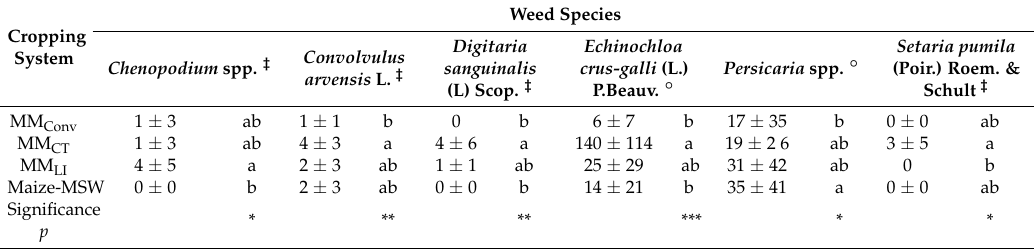
Figure 3. Mean weed biomass at three stages of maize growth in the four cropping systems (MM Conv : conventional maize monoculture; MM CT : conservation tillage maize monoculture; MM LI : low-input maize monoculture; Maize-MSW: integrated maize rotation). Weed biomass at the 6–8 leaf stage was sampled only in 2014 and 2015 ( N = 4 quadrats per cropping system) whereas weed biomass at the flowering and maturity stage was sampled from 2011 to 2015 ( N = 10 quadrats per cropping system). Year and block were treated as random factors. Error bars represent standard deviation. ANOVA tested for system effect (6–8 leaf: p < 0.001; Flowering: p = 0.01; Maturity: p < 0.001). Bars sharing the same letter (“a” and/or “b”, and/or “c”) within each crop stage are not significantly different ( p < 0.05, Tukey HSD Test). Sampling (days after sowing): 8 leaf (48–58), flowering (76–113), maturity (140–179). Table 3. Biomass of weed species (mean ± standard deviation, g DM m − 2 ) between the cropping systems (MM Conv : conventional maize monoculture; MM CT : conservation tillage maize monoculture; MM LI : low-input maize monoculture; Maize-MSW: integrated maize rotation) at maize maturity (140–179 days after sowing). For each weed species, mean values followed by a same letter (“a” and/or “b”) are not different according to Tukey’s HSD test (denoted with ◦ ) or, when ANOVA assumptions were not met, the Kruskal-Wallis test (denoted with ‡ ) (* p < 0.05, ** p < 0.01, *** p < 0.001). Cropping